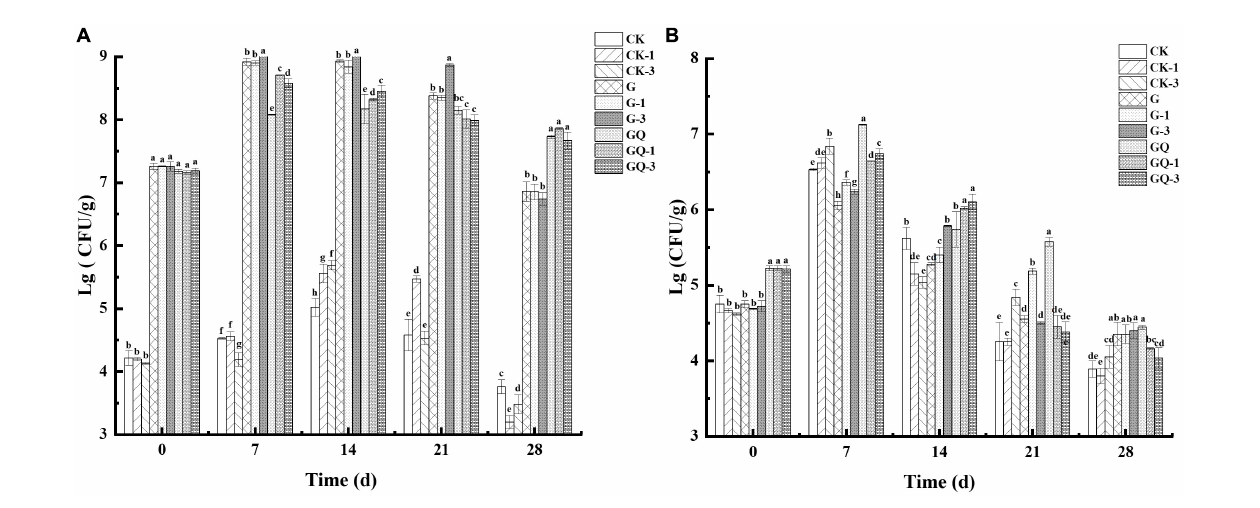
FIGURE4 Changes in viable counts of LAB (A) and staphylococcus (B) in sausages among treatments during the fermentation for 0, 7, 14, 24, and 28 days. Different lowercase letters (a–h) indicate a significant difference between different treatment groups at the same fermentation time ( P < 0.05). The group without starter culture and leucine was assigned to the CK group. The groups added with 1 and 3 mM of leucine without starter culture were assigned to the CK-1 and CK-3 groups, respectively. The group with Lactobacillus fermentum YZU-06 was assigned to the G group. The groups with Lactobacillus fermentum YZU-06 and different concentrations of leucine (1 and 3 mM) were named G-1 and G-3 groups, respectively. The fermented sausage with the mixed-starter cultures of Lactobacillus fermentum YZU-06 and Staphylococcus saprophyticus CGMCC 3475 was assigned to the GQ group. The groups with the mixed-starter cultures and different concentrations of leucine (1 and 3 mM) were named GQ-1 and GQ-3 groups, respectively.